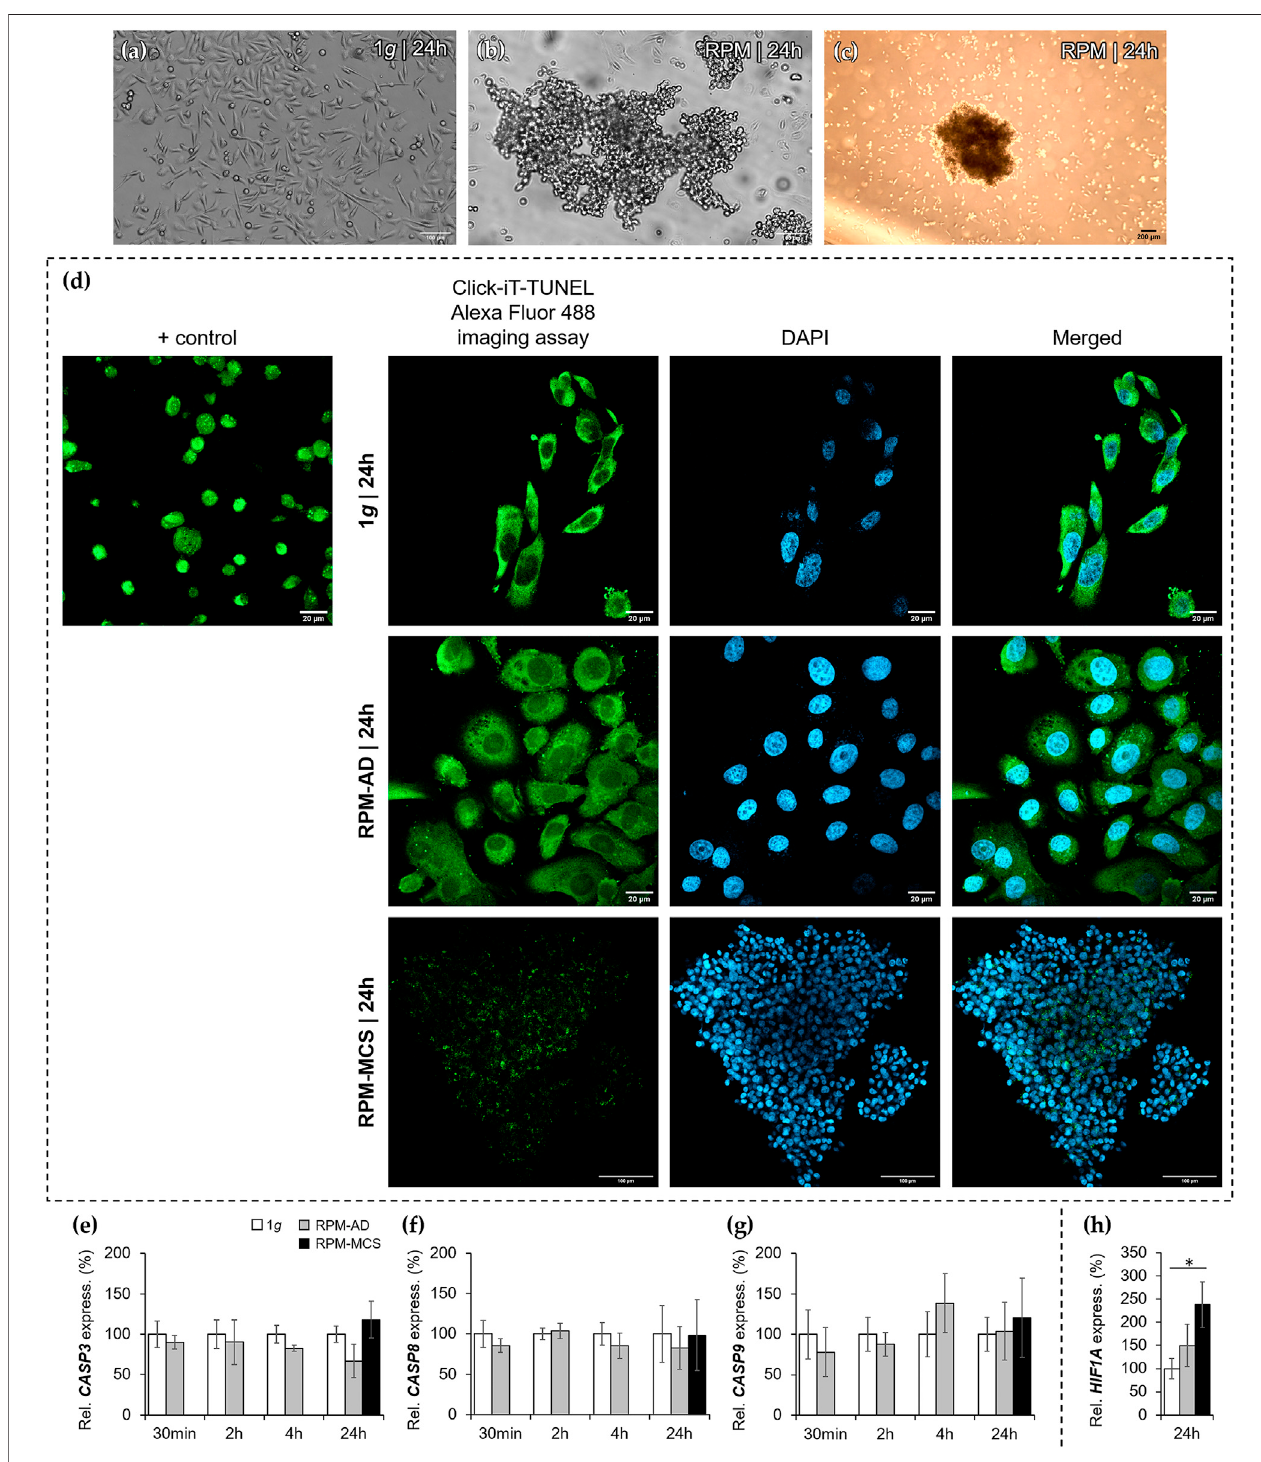
FIGURE 1 | Phase contrast microscopy of PC-3 cells: (A) static 1 g control cells (Scale bar 100 µm) and (B,C) 24 h RPM-exposed samples showing detached spheroids swimming above adherently growing cells (scale bar (B) 100 µm and (C) 200 µm). (D) Terminal deoxynucleotidyl transferase dUTP nick end labeling (TUNEL) assay and 4 ′ ,6-diamidino-2-phenylindole (DAPI) staining revealed no apoptotic cells in 1 g controls (scale bar 20 µm) and also no apoptosis in RPM-exposed AD (scale bar 20 µm and MCS cells (scale bar 100 µm). The positive control, induced by DNase, is given in the fi rst row (Scale bar 20 µm). (E,F,G) The CASP3, CASP8 and CASP9 (30 min, 2, 4and 24 h) gene expression wasnot signi fi cantly altered at all time points. (H) The gene expression of HIF1A after 24 h wasnot changed in AD cells, but signi fi cantly elevated in MCS compared to 1 g (n = 5).